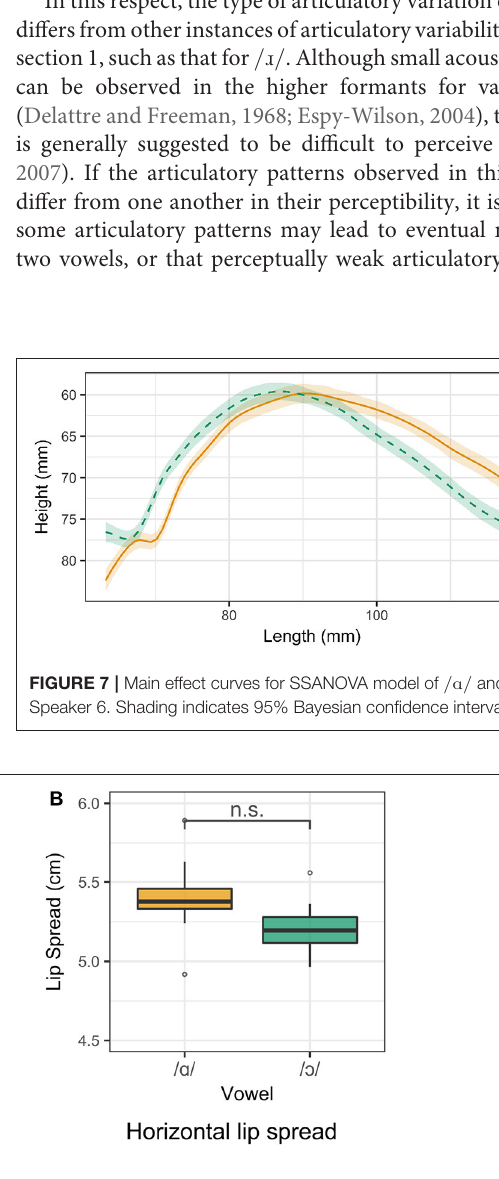
Frontiers in Psychology |